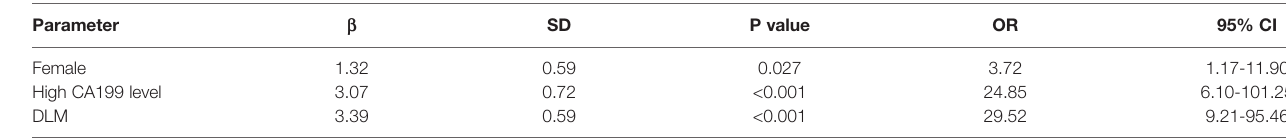
TABLE 1 | Multivariable analysis of clinical features and US-DLM in training cohort for predicting OM in cirrhotic liver. Parameter b